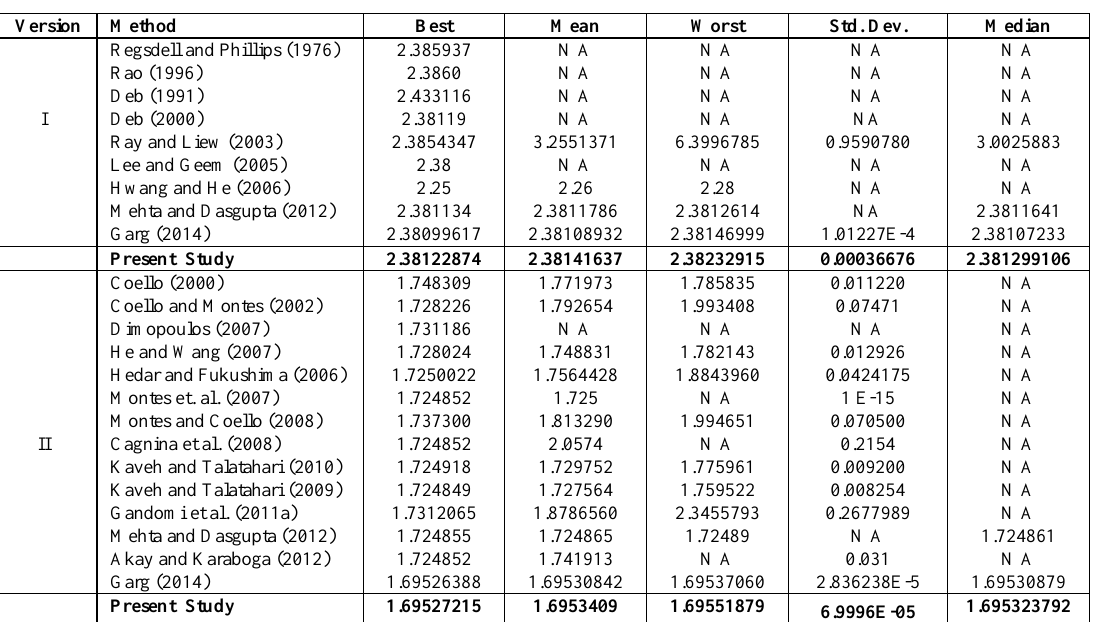
Table 4. Statistical results of different methods for welded beam design